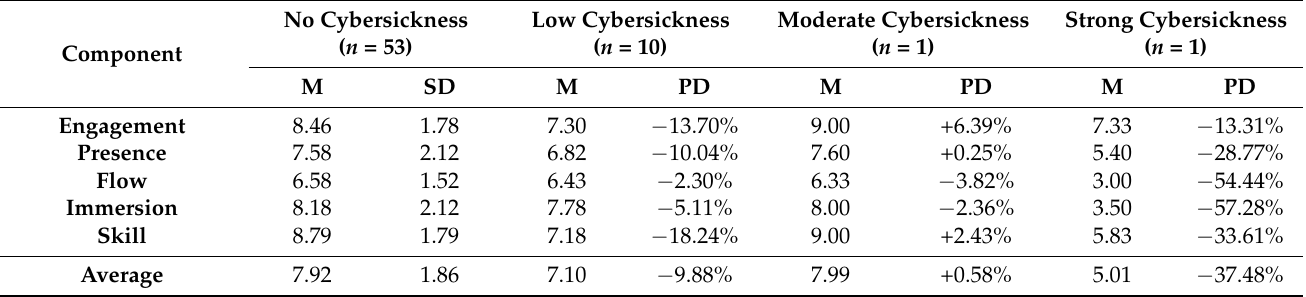
Table 3. Mean (M) and average and its standard deviation (SD) results of the usability and satisfac- tion survey for each level of cybersickness and their Percentage Difference (PD) with the no-cyber- sickness group.